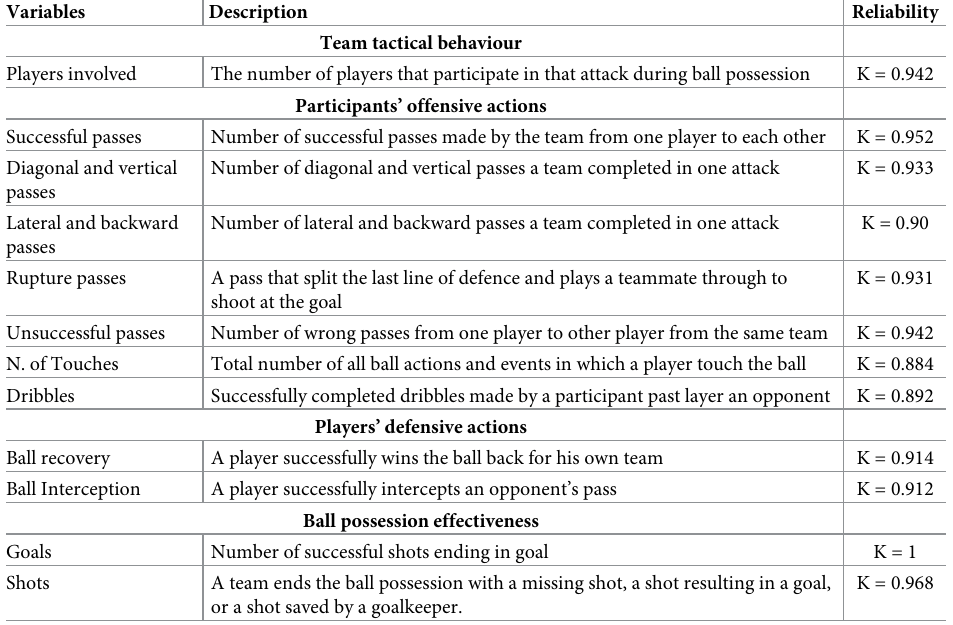
Table 1. Description of the independent